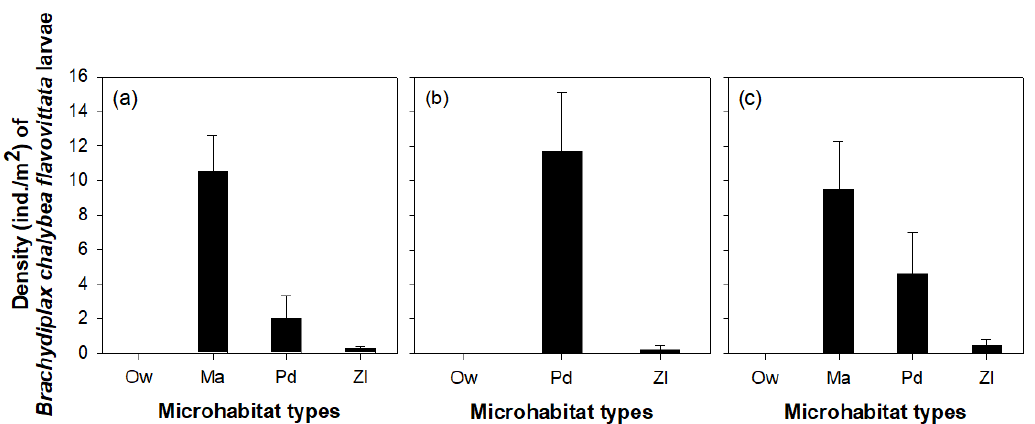
Figure 4. Density of Brachydiplax chalybea flavovittata larvae according to microhabitat type: Ow, open water area; Ma, area covered by Myriophyllum aquaticum ; Pd, area covered by Paspalum distichum ; Zl,